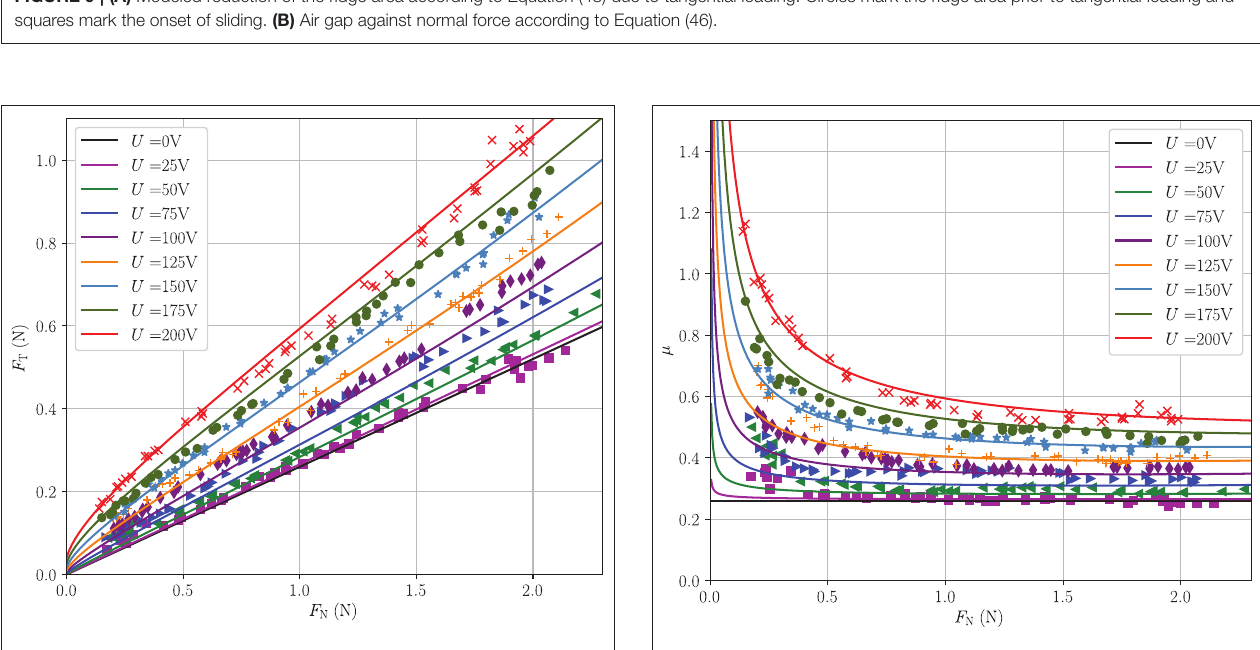
FIGURE 11 | Model predictions and experimental results by Sirin et al. (2019a) of the apparent coefficient of friction against normal force for voltages of 25–200